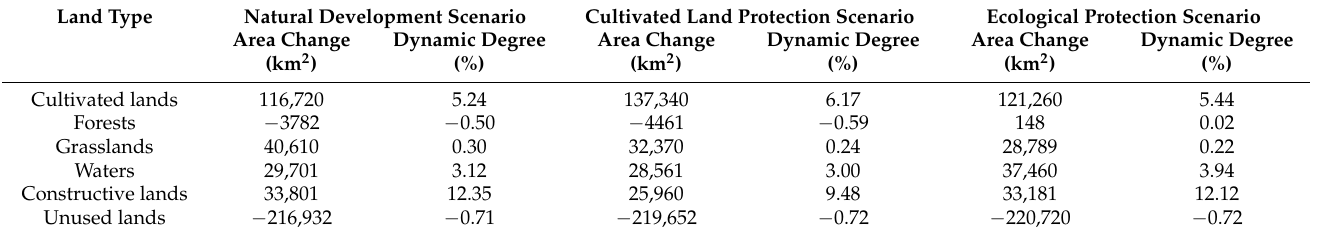
Table 4. Dynamic changes of land types in the arid desert region of Northwest China under different scenarios from 2020 to